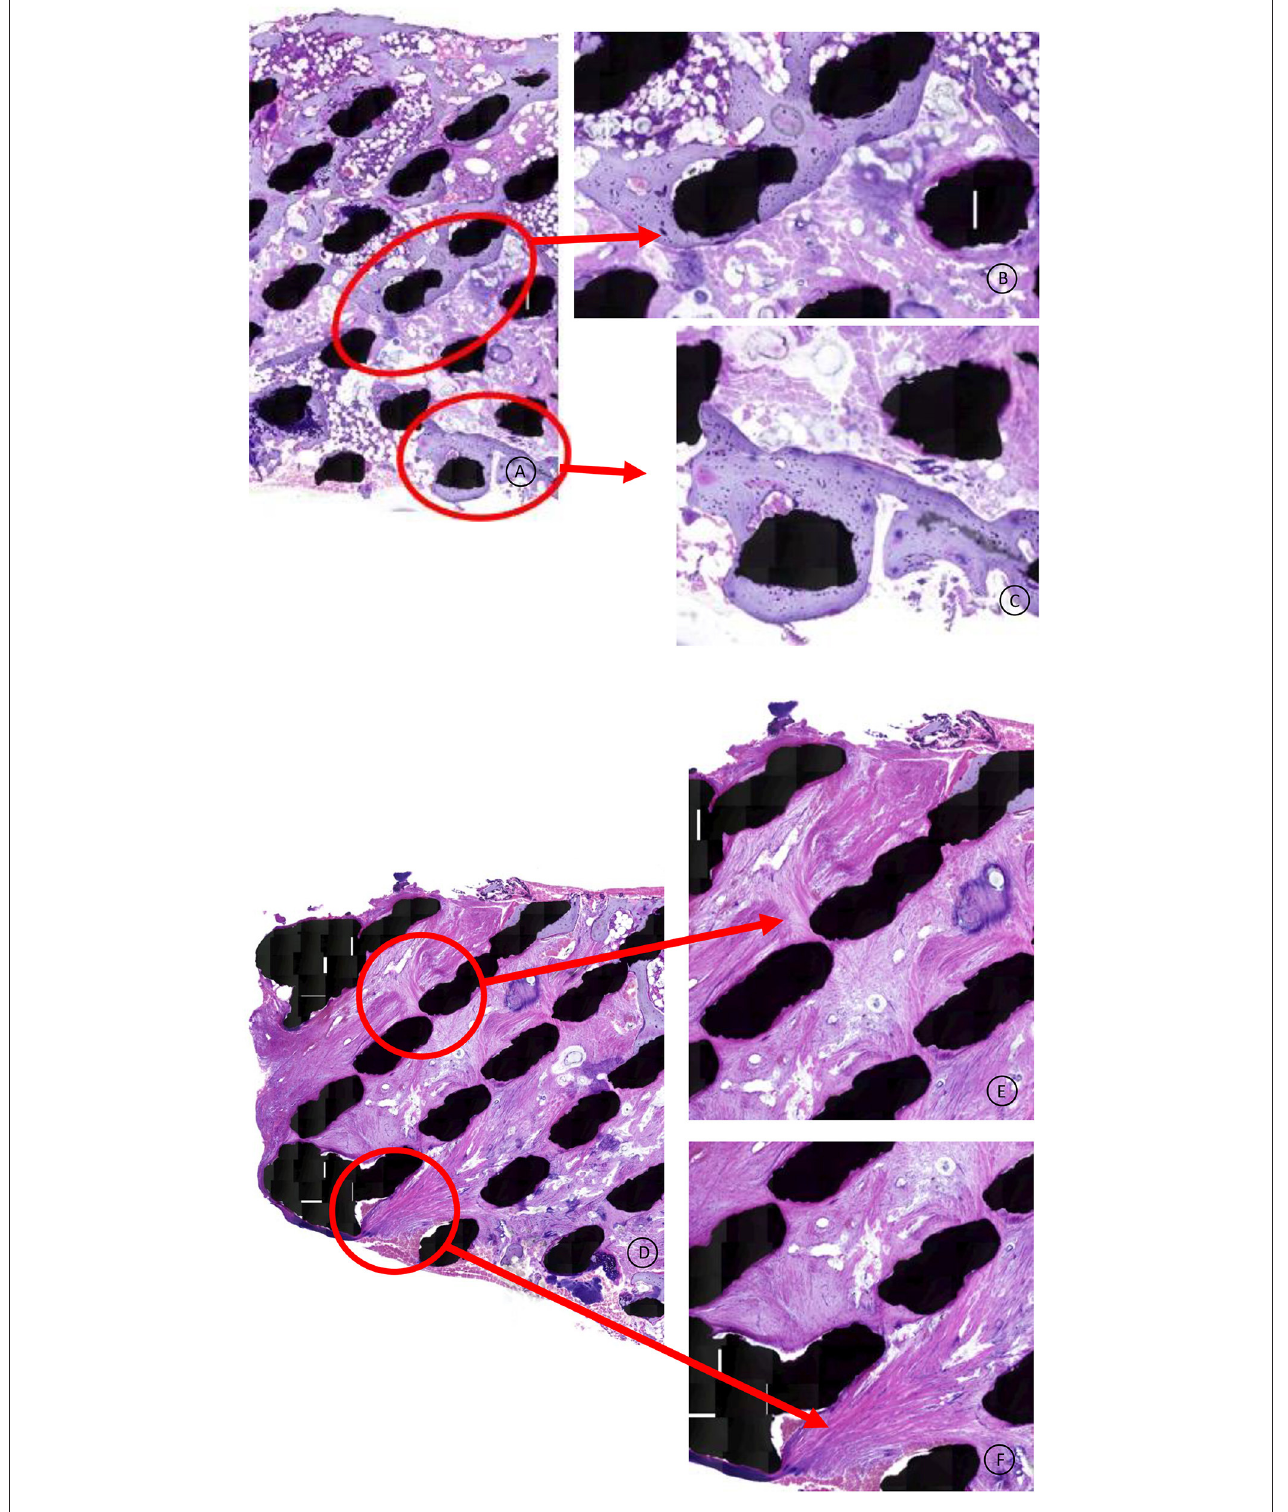
FIGURE 5 | (A–C) HE stained specimen: Higher magnification from the cage middle and surface area. The lamellar bone has a mature, vivid appearance without any fibrous tissue intervening between the titanium and the bone. Healthy bone marrow can be observed throughout the scaffold. (D–F) HE stained specimen: Higher magnification from the posterior 1/3th of the cage. Dense collagen fibers are directed in a cranial to caudal trajectory, attaching to the titanium struts.